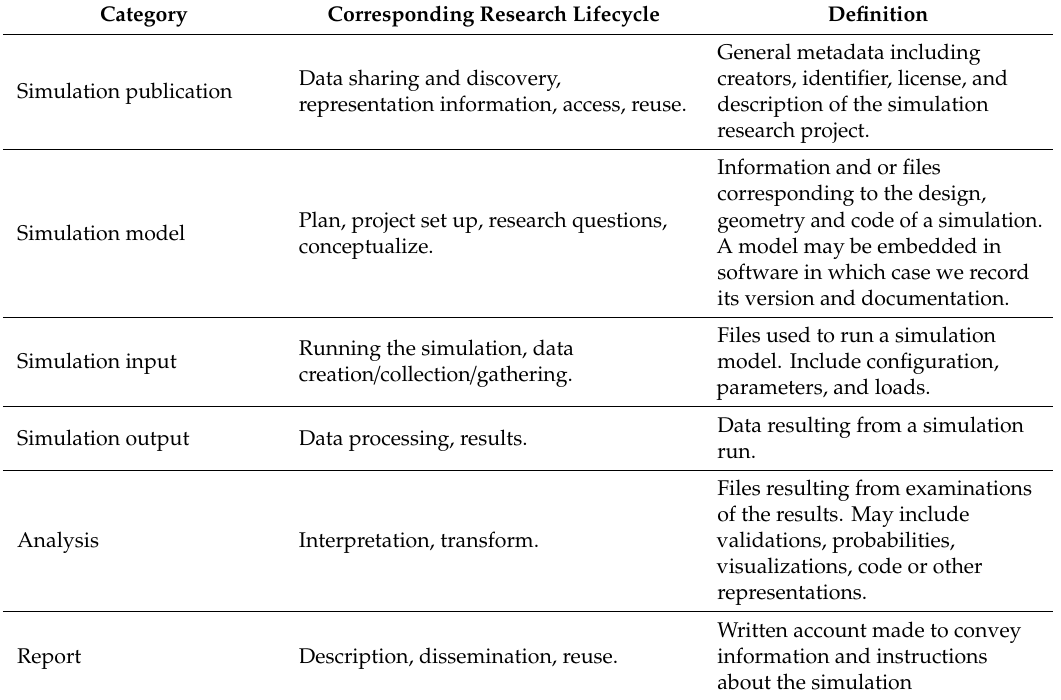
Figure 1. Drawings of research workflows made by simulation experts: Clint Dawson (storm surge simulation) ( left ); and Laura Lowes (structural simulation) ( right ). Table 1. Simulation Data Model Categories and Correspondence with Research and Curation